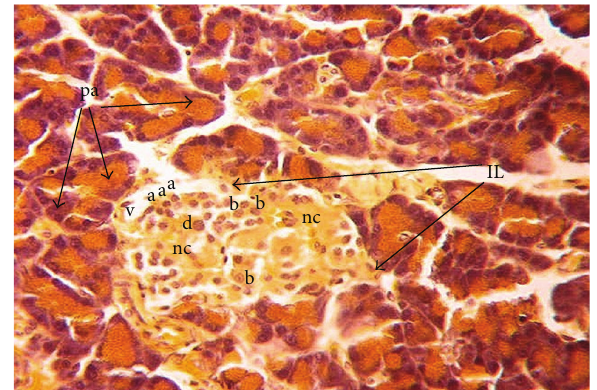
Figure 4: Photomicrograph of pancreas section of diabetic rat offspring after one week of birth showing very small islets of Langerhans (IL) with many necrotic foci (nc) and vacuolations (v) ( × 400).